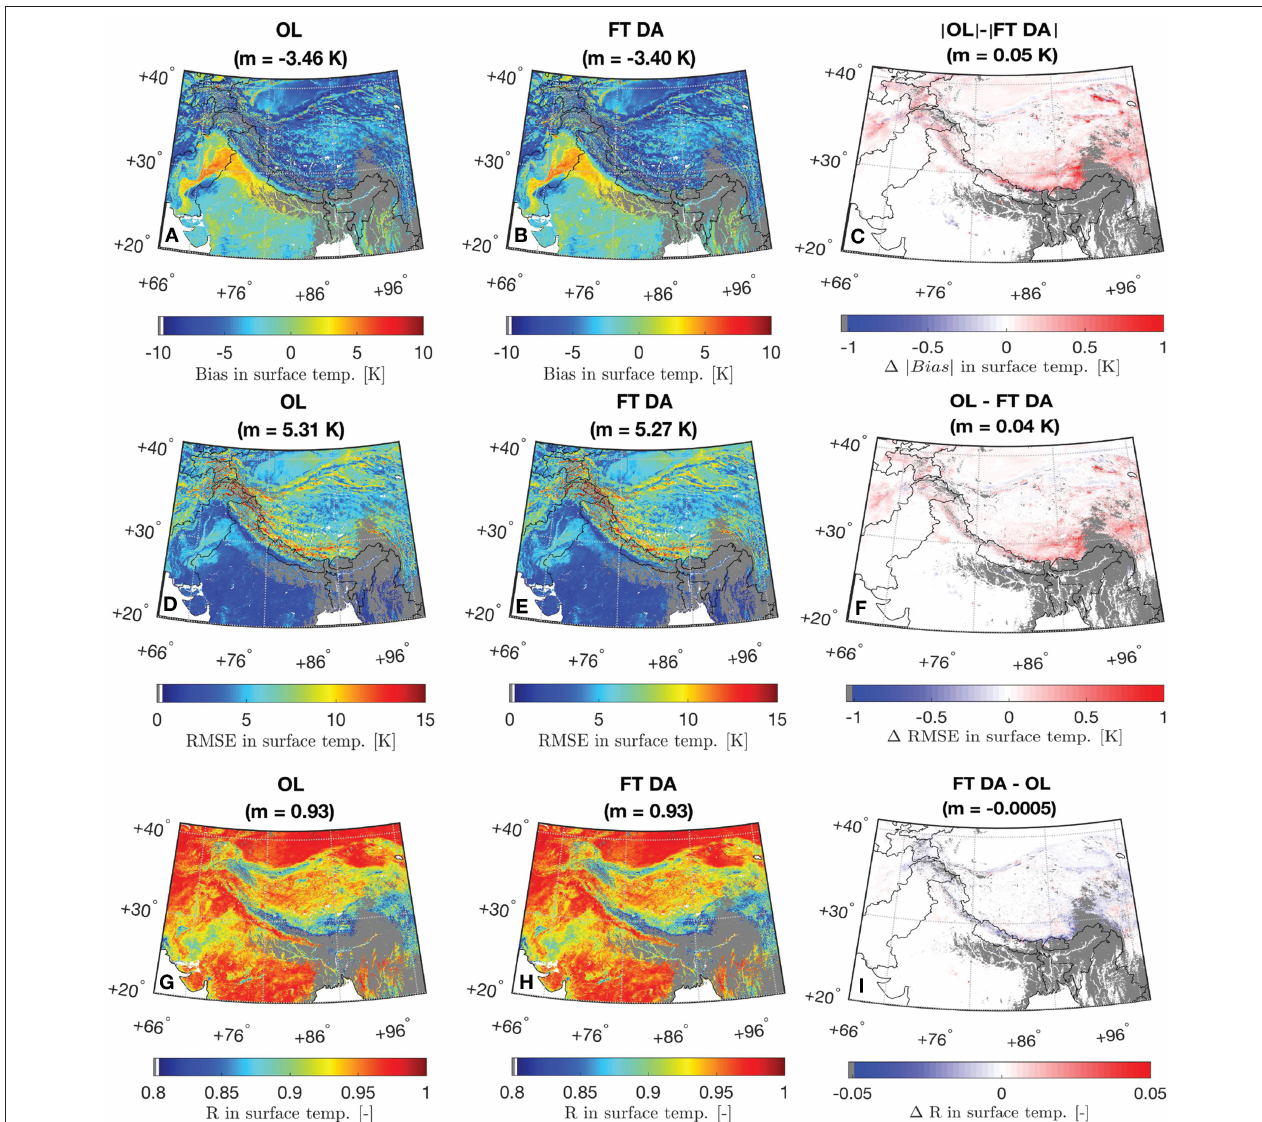
FIGURE 6 | Spatial distribution of bias, RMSE, and R computed between daily-averaged (A,D,G) OL surface temperature and MODIS derived surface temperature, and (B,E,H) FT DA surface temperature and MODIS derived surface temperature. Spatial distribution of the change in the absolute value of bias ( 1 | bias | ) between OL and FT DA is shown in (C) . The |·| operator in the title denotes taking the absolute value of each corresponding bias. Spatial distributions of the change in the RMSE and in the R are shown in (F,I) , respectively. The red colors in (C,F,I) indicate FT DA agrees better with MODIS derived measurements than OL. Conversely, blue colors indicate that OL agrees better with MODIS. The title also demonstrates the spatial mean, m, computed for each map. Gray regions indicate grid cells with inadequate presence (i.e., <60 days) of MODIS derived daily-averaged measurements computed using Equation